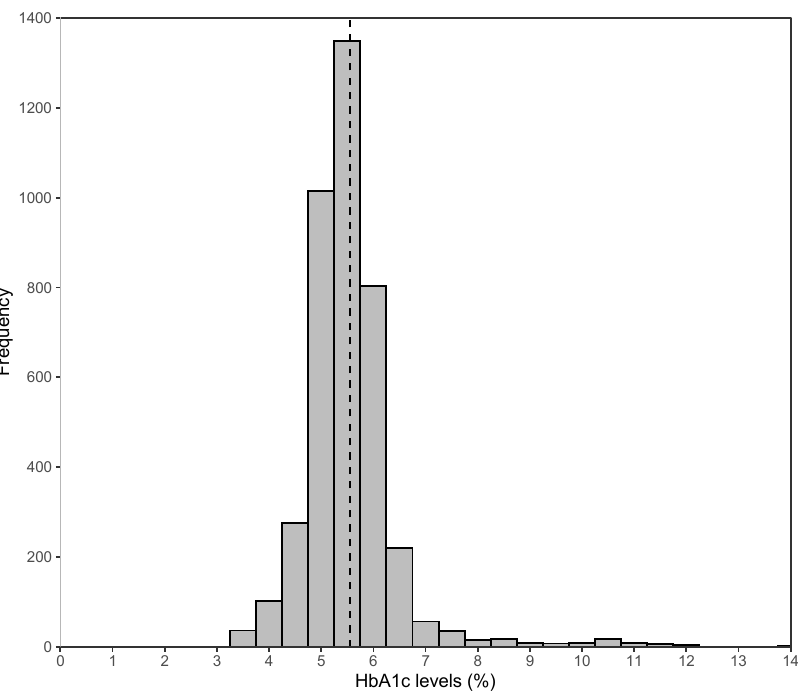
Figure 5. Distribution of HbA1c levels (%) among the IFLS5 sample (4000 respondents aged 18 and above). Note: Dashed line indicates the mean at 5.55%. The minimum was 3.50% and the maximum was 14.0%.